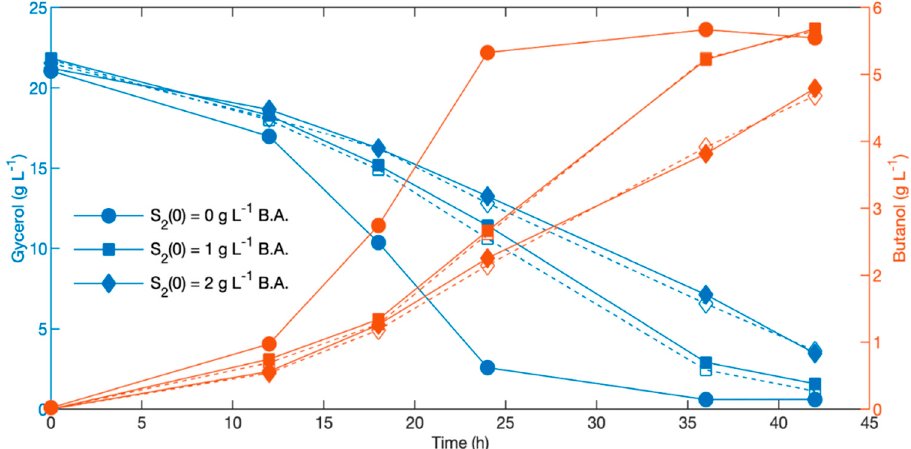
Figure 2. Growth of Clostridium pasteurianum in media containing differing amounts (0, 1, or 2 g/L) of chemically pure butyric acid (solid lines, filled symbols) or butyric acid rich supernatant from xylose fermentation (dotted lines, unfilled symbols). Blue line = substrate concentration; Orange line = butanol concentration. C-source: 20 g/L glycerol, T = 35 ° C, V l = 30 mL, 0.05 M citric acid buffer added, pH o = 5.3. All conditions were tested in duplicate with the mean of the results presented. Deviation from the mean was less than 10% for all samples.